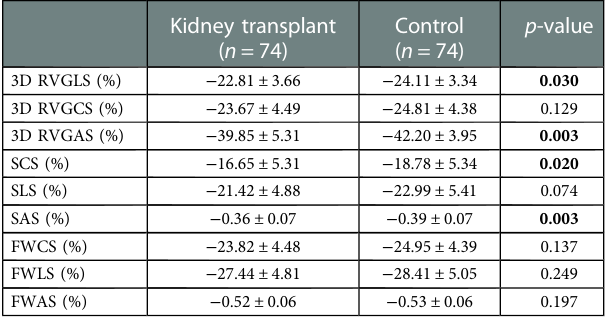
TABLE 4 Comparison of 3D right ventricular data measured by our custom ReVISION method in the kidney transplant and the control groups.